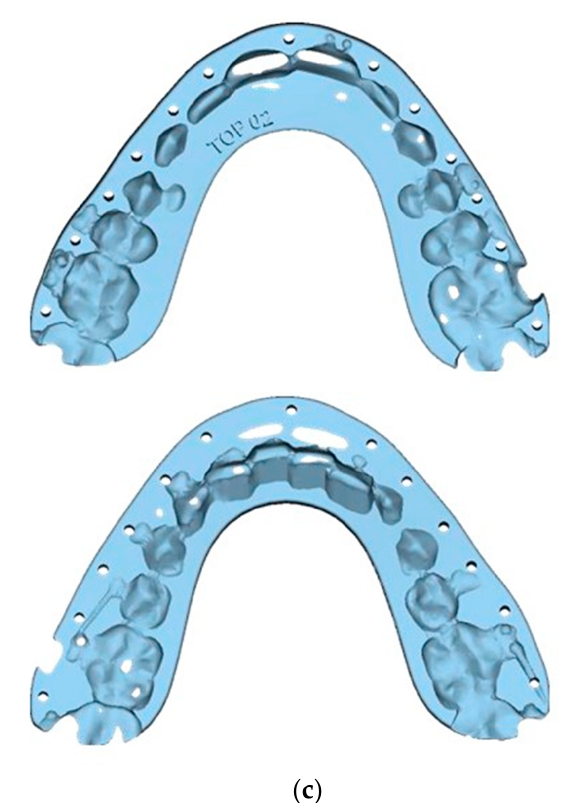
Figure 6. Guide Design and Final Splints : ( a ) Frontal view; ( b ) Right side view; ( c ) Splints.